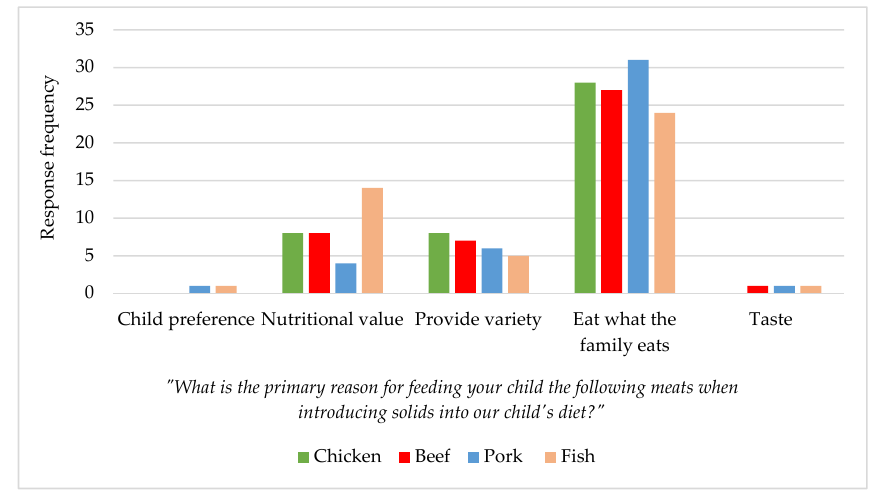
Figure 3. Idaho parent/caregiver primary reason for choosing meat when introducing solids. Subjects were asked in the form of an electronic Qualtrics survey ( n = 45).